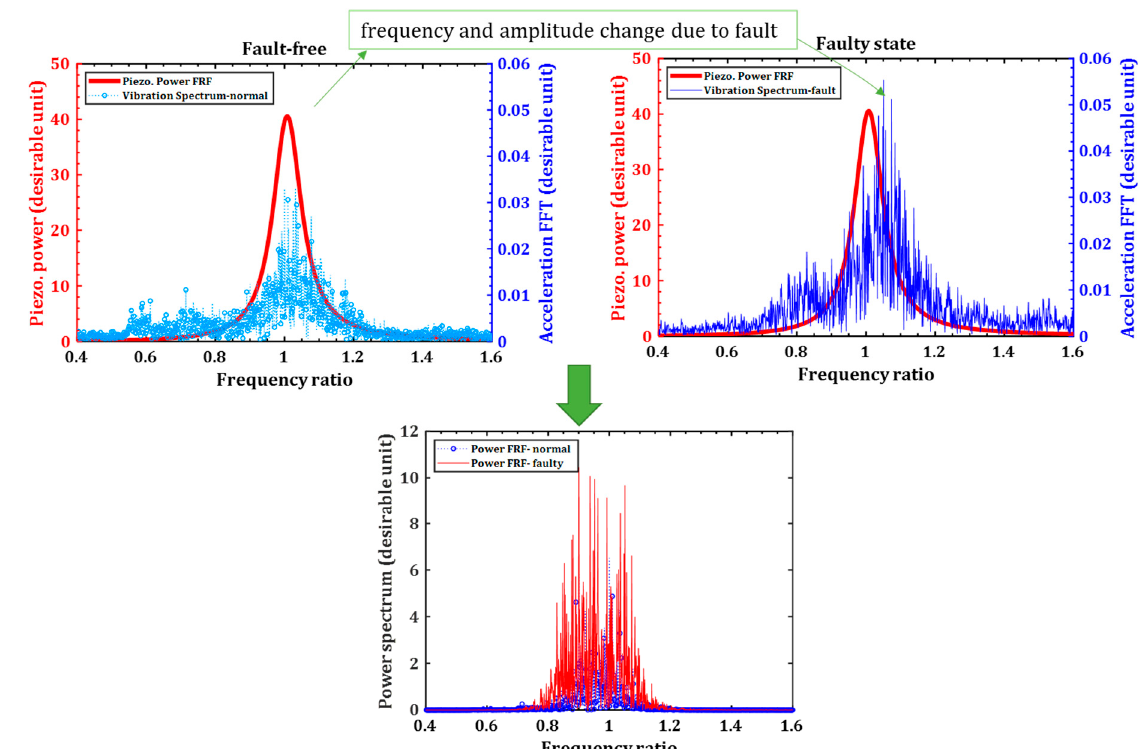
Figure 2. Sensitivity analysis of a piezoelectric transducer to the fault.